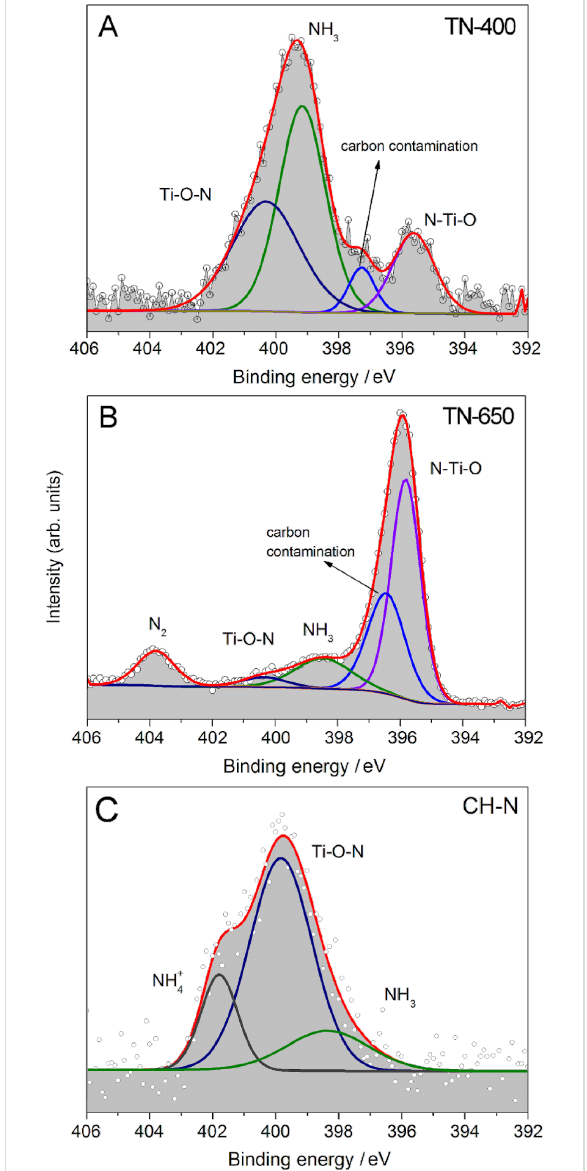
Figure 7: Nitrogen 1s XPS spectra of N-doped TiO 2 nanoribbons derived from hydrogen titanate nanoribbons resulting from a heat treat- ment in an NH 3 (g)/Ar(g) flow at 400 °C (A) and 650 °C (B), and hydrothermally in 0.5 M NH 3 (aq) at 160 °C (C).